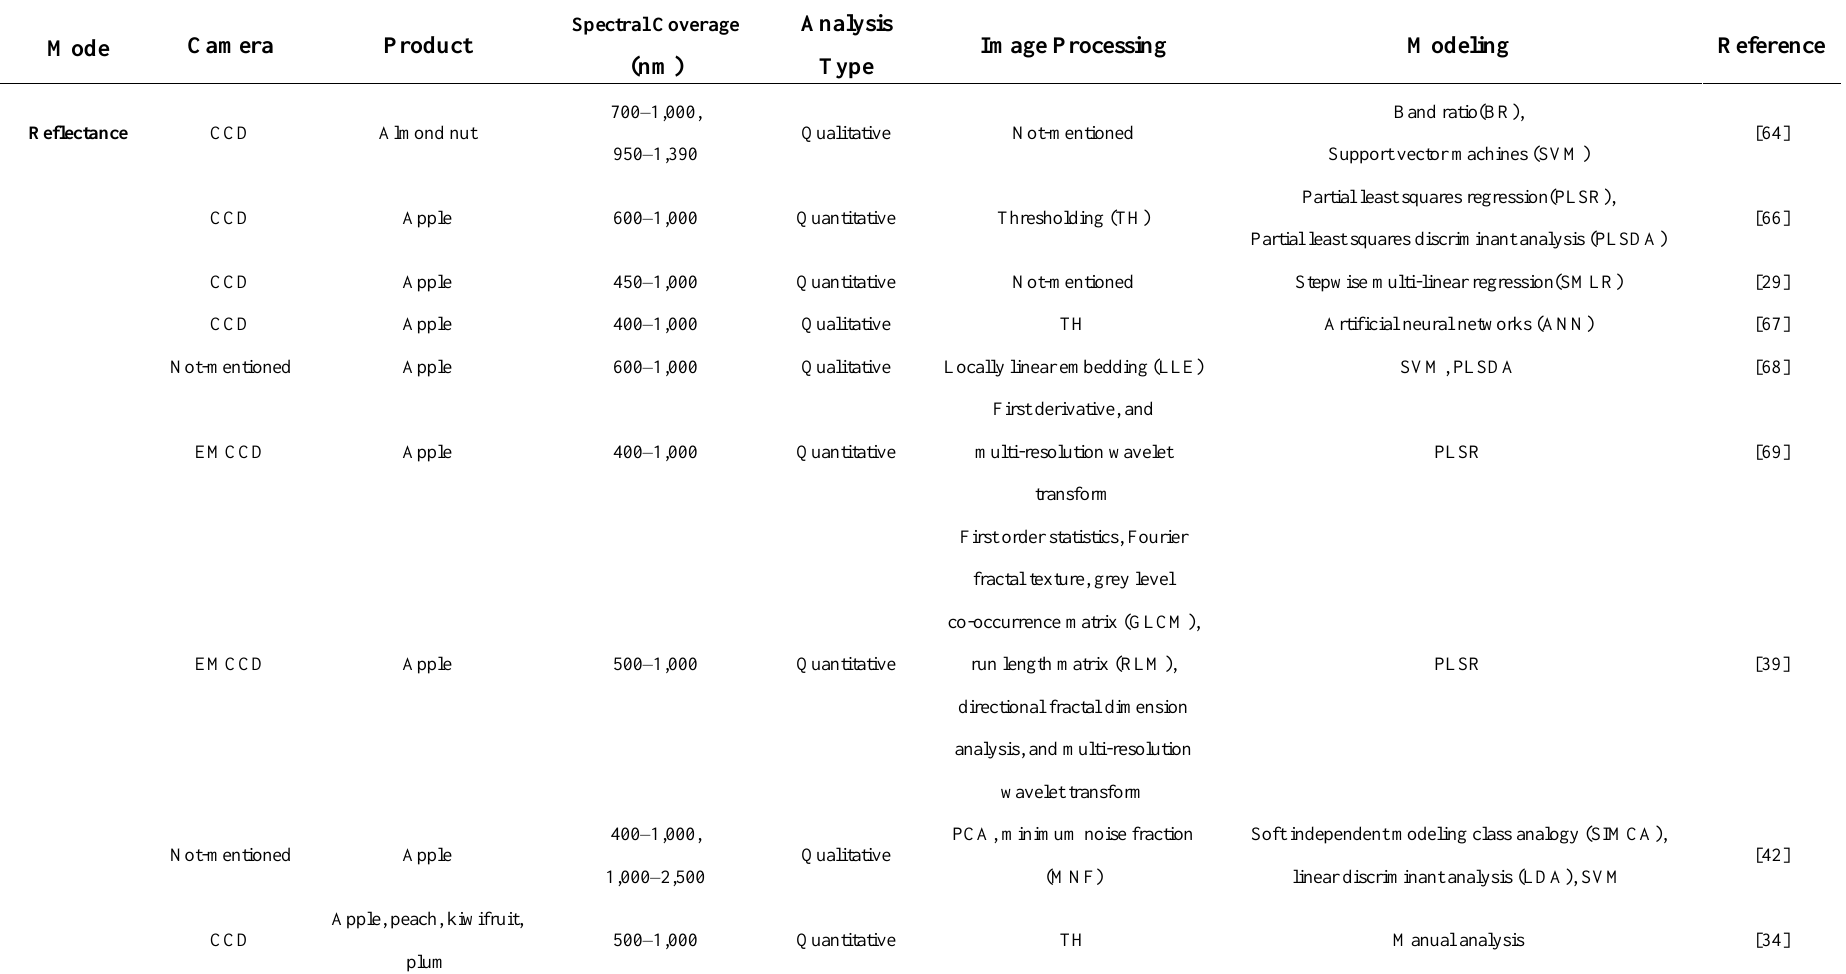
Table 1. Summary of measurement mode, product type, analysis type, wavelength region, and modeling algorithm in representative papers published on hyperspectral imaging of food since